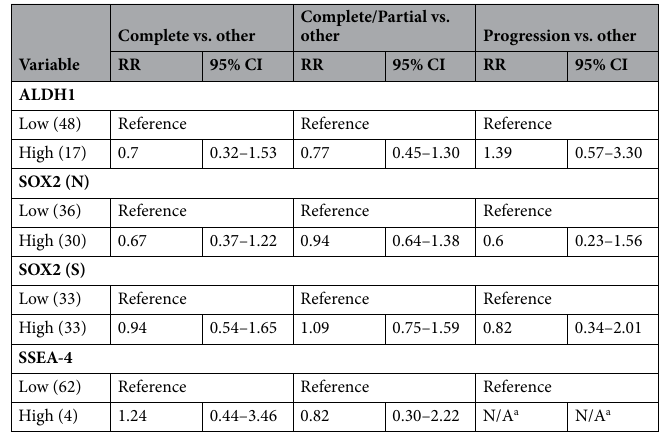
Table 5. Association between high expression (H-score ≥ 4) of markers in TUR-BT samples and neoadjuvant chemotherapy response, where low expression (H-score < 4) is reference. Number of patients is shown in brackets for each subgroup. a There was no disease progression among the patients with high SSEA-4 H-score, and therefore the association with progression could not be tested.